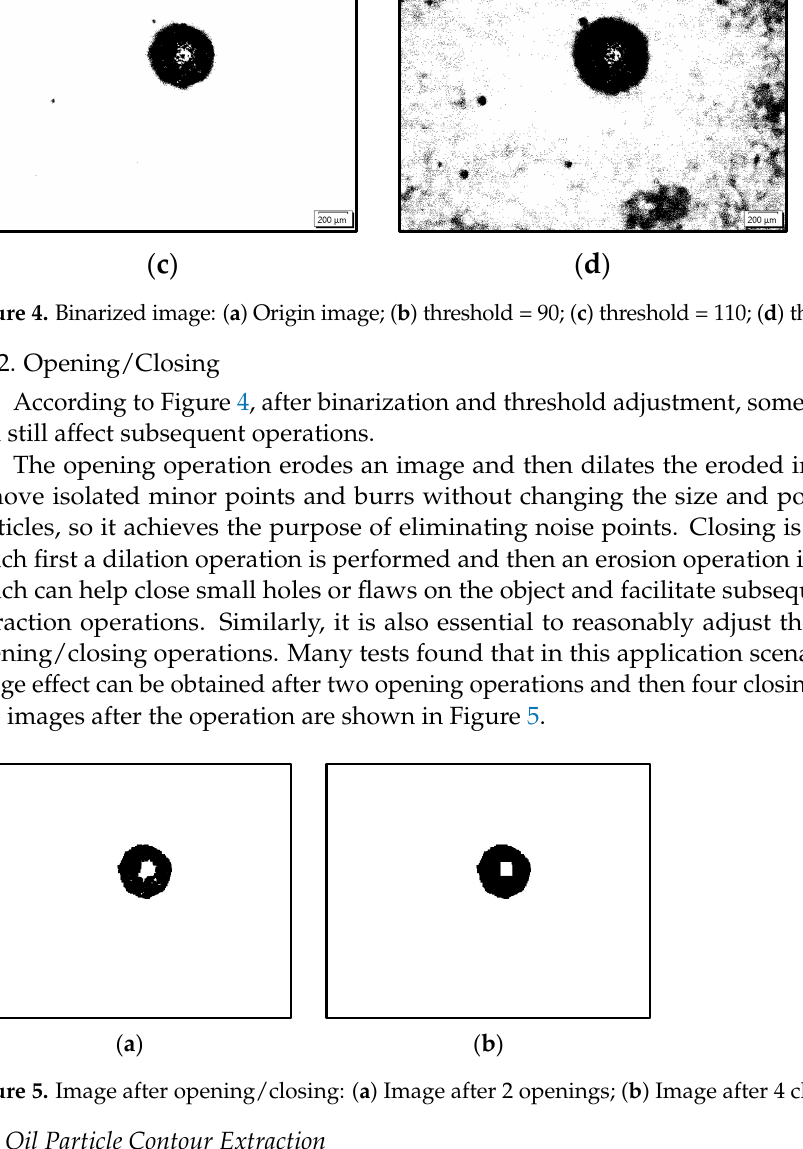
Figure 5. Image after opening/closing: ( a ) Image after 2 openings; ( b ) Image after 4 closings.